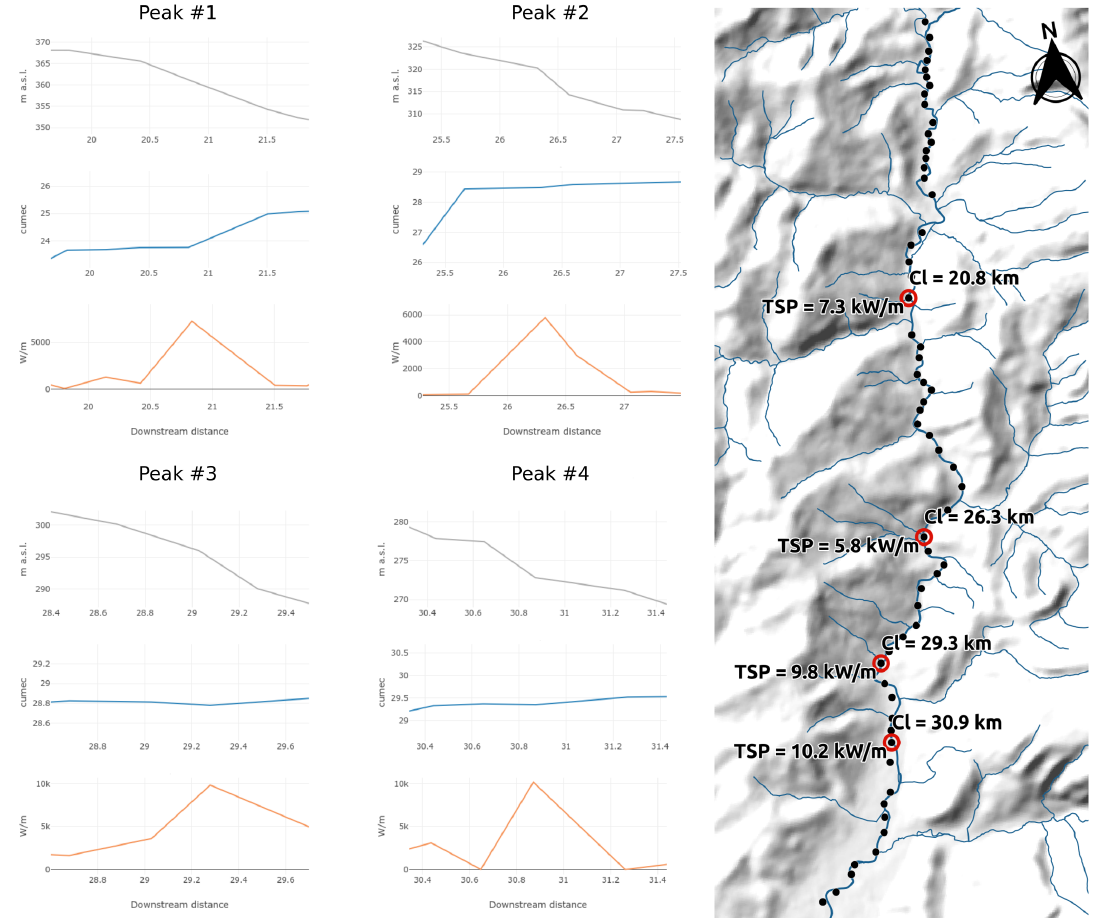
Figure 10. The left part of the figure shows the line plots for the elevation profile (in gray), discharge (in blue), and TSP 100 m upstream (in orange) for Peaks #1–4. On the right, the map shows the location for the four peaks; the label reports the downstream Channel length (Cl) and the TSP expressed in